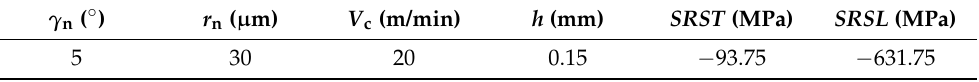
Table 10. Optimal cutting conditions for maximizing the compressive residual